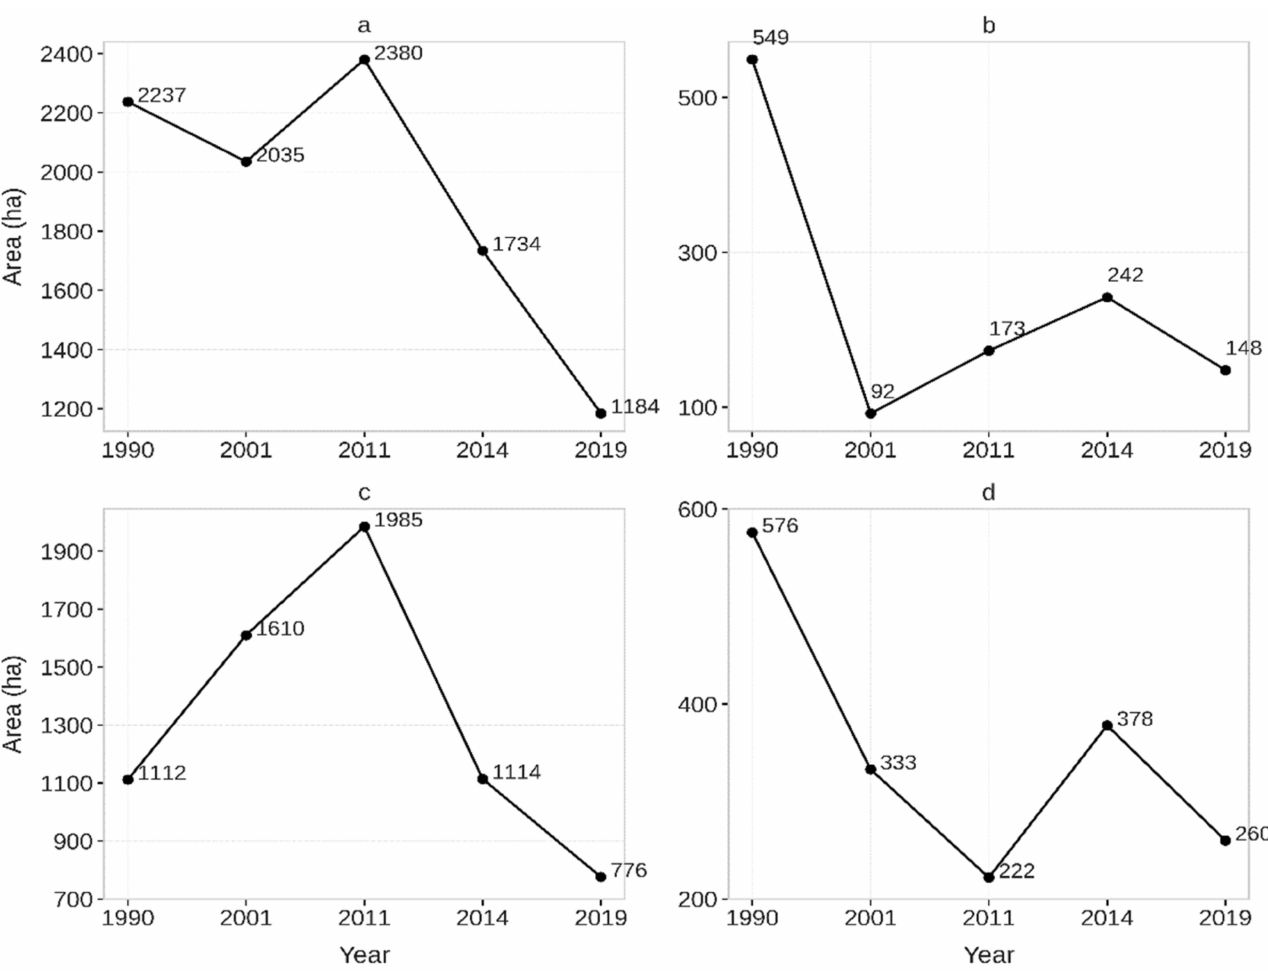
Figure 4. Seagrass area in Tauranga Harbour from 1990–2019 derived from Landsat imagery with the variation in: ( a ) entire harbor; ( b ) northern harbor; ( c ) central harbor; ( d ) southern harbor. The distribution of seagrass has also changed over time. In 1990, the meadows were similarly abundant in the northern, central, and southern harbors. Declines to 2001 mostly reflected losses from the northern and southern meadows, while the central meadows remained and were responsible for most of the expansion between 2001 and 2011 (Figures 3 and 5). After 2011, there was no detectable recovery of the northern or the southern meadows, and the renewed overall decline was due to degradation of the central meadows, declining in area and becoming patchier by 2019 (Figures 3 and